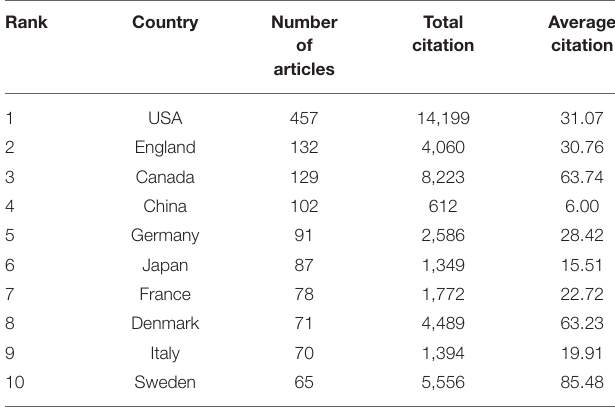
TABLE 1 | List of top 10 countries according to the total number of